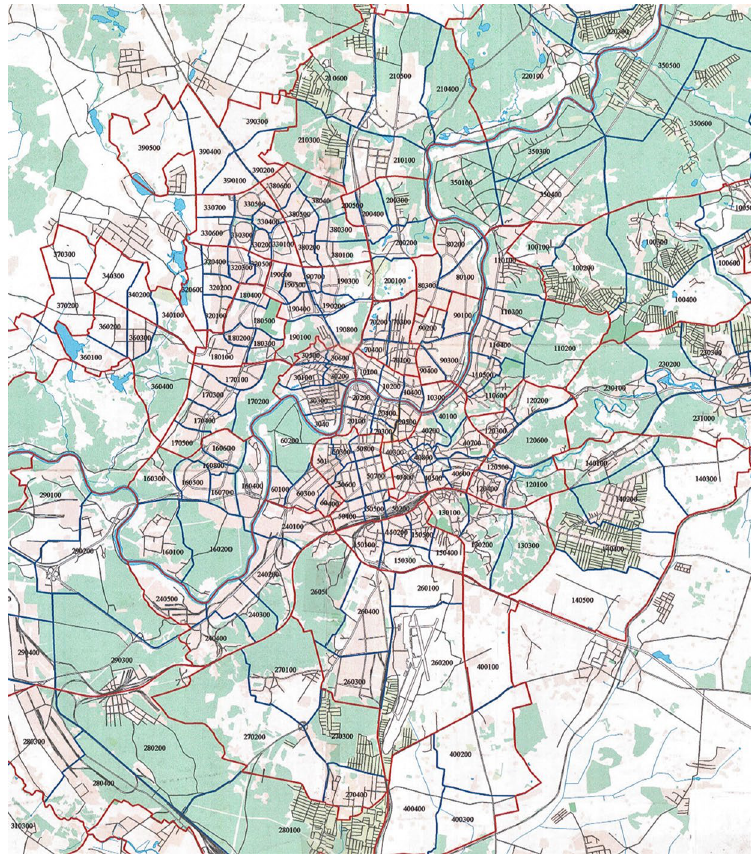
Fig. 4. The division of Vilnius City into transport